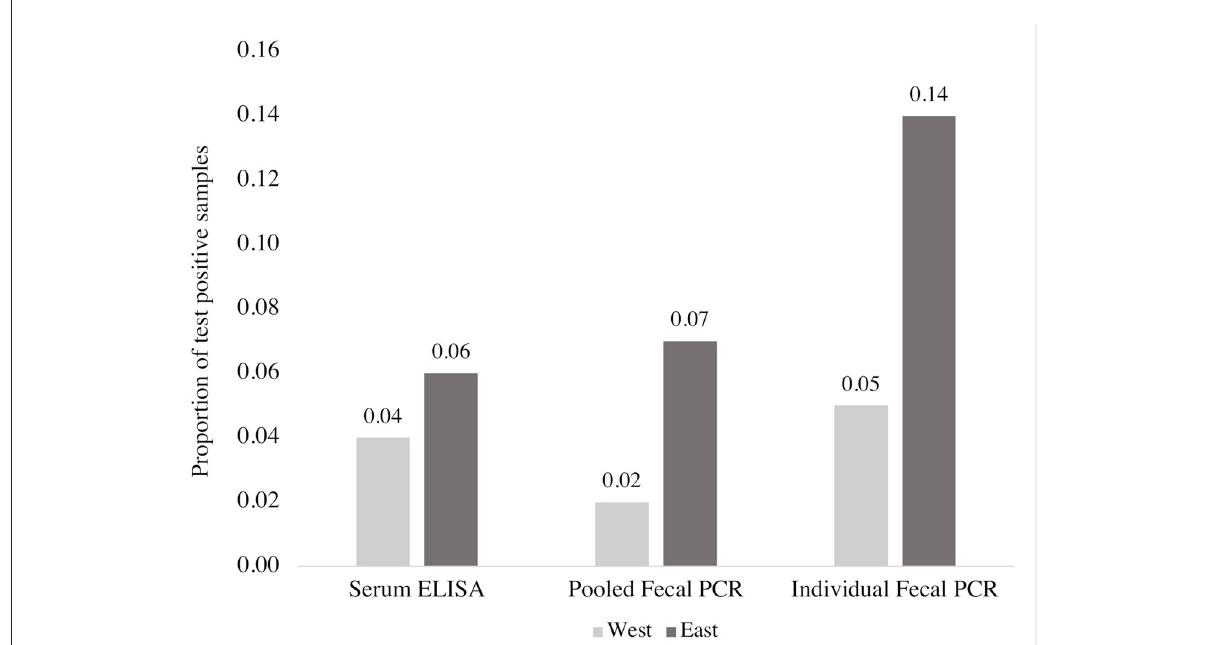
FIGURE3 Comparison of the proportion of MAP positive blood and fecal samples detected by ELISA, fecal PCR (pools of five fecal samples) and individual fecal PCR from a subset of 913 beef cows according to region. This figure reflects data from a non-representative subsample of the overall data set (913 of 3,171 samples).